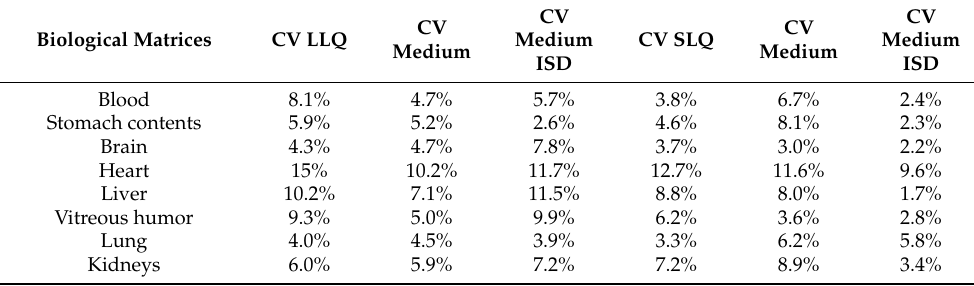
Table 14. Coefficient of variation (CV) of the lower limit of quantification (LLQ) and the superior limit of quantification (SLQ), as well as the average CV (average of the CV of the other points of the calibration curve), and of the internal standard (ISD) in the different matrices, expressed in percentage of aldicarb–sulfone.